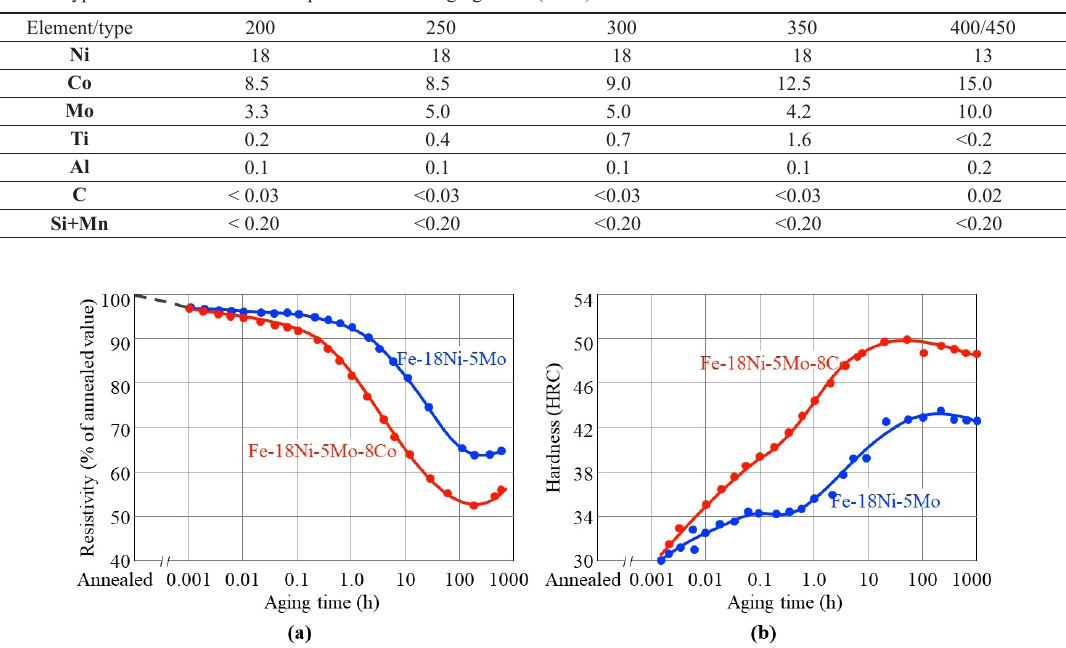
Figure 4. Effect of the addition of 8% Cobalt on the variation of the electrical resistivity(a) and the Rockwell C hardness (b) in a Fe- 18%Ni-5%Mo alloy 33,34